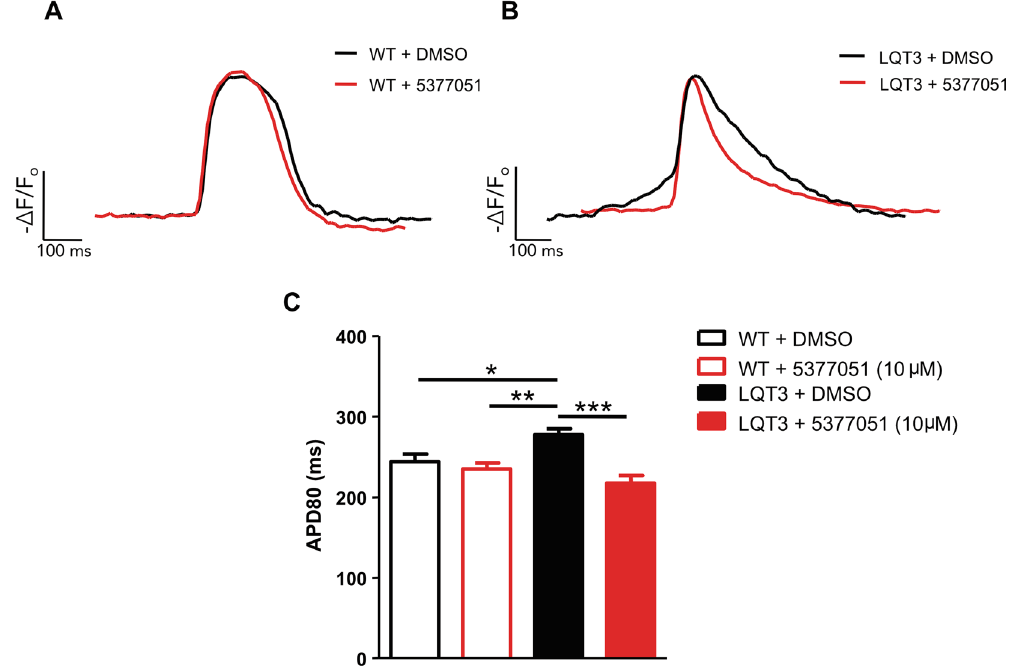
Figure 7. Treatment with SGK1 inhibitor 5377051 restores prolonged APD in a cellular model of LQT3. ( A ) Representative fluorescent tracings of spontaneous action-potentials from wild-type hiPSC-CMs expressing ArcLight with or without the SGK1 inhibitor 5377051 quantified by measuring the action potential duration at 80% repolarization (APD80) (WT + DMSO, 244 ± 9 ms, n = 15 versus WT + 5377051, 235 ± 8 ms, n =